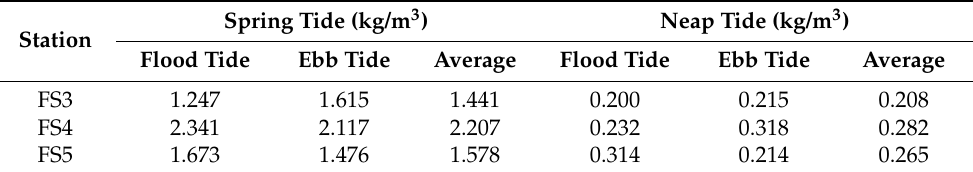
Table 2. Time-averaged S values during the wet season (2nd half of June 2015).